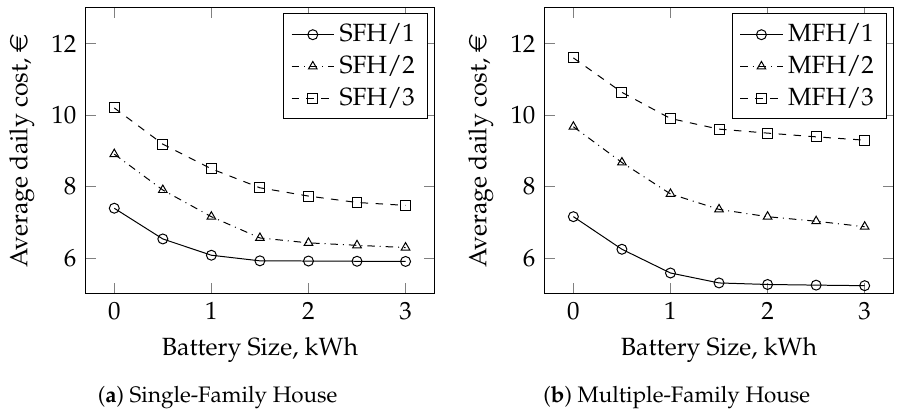
Figure 8. Influence of battery size on daily cost, for different house occupancies for SFH ( a ) and number of families per MFH ( b ). Climate Zone 5, setting WSB, tank 800 L,